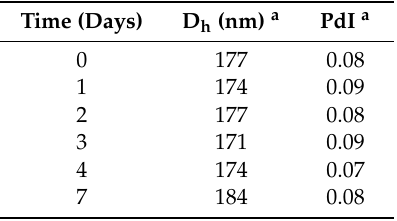
Table 3. Evolution of the droplet diameter with time for a styrene miniemulsion prepared using the rotor-stator mixer and the recipe in Table 1 with HD as the hydrophobe.